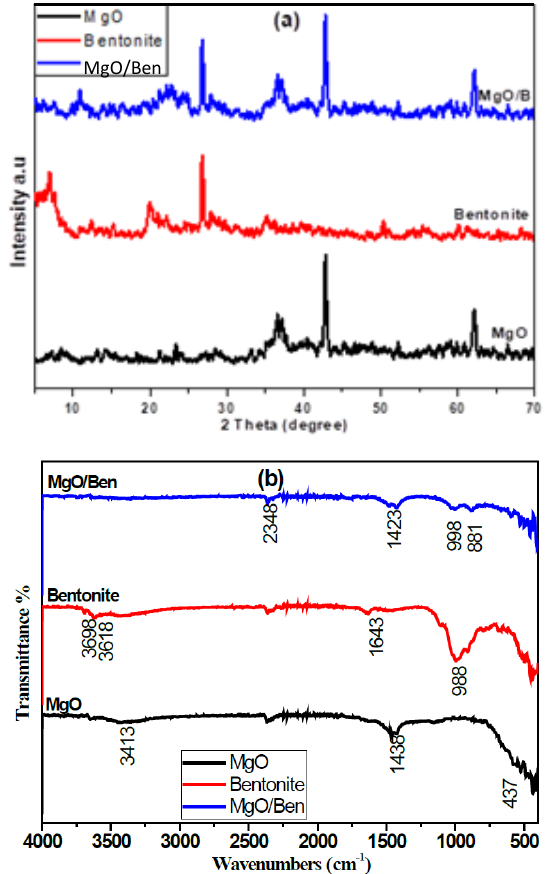
Figure 1. The XRD patterns ( a ), FTIR spectra ( b ) of the prepared MgO NPs, bentonite, and MgO/Ben nanocomposite.